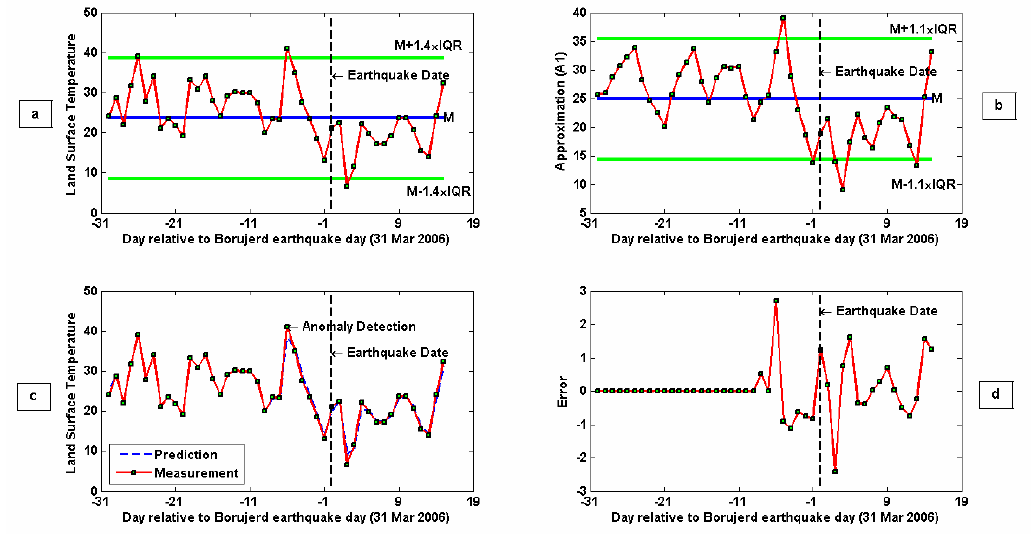
Fig. 6. Same as Figure 4 but for the Borujerd earthquake (31 March 2006) from 1 March to 15 April 2006.